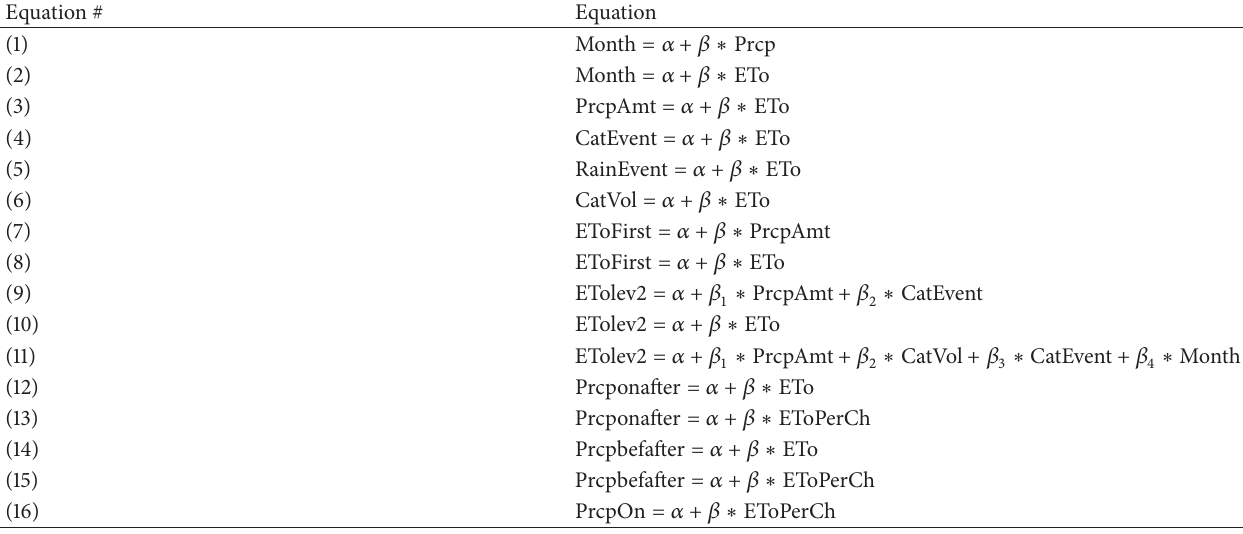
Table 3: Equations used to test the relationship among seasonality, precipitation, and evapotranspiration. All equations were modeled using the logit link (i.e., logistic equations, Agresti, 1996